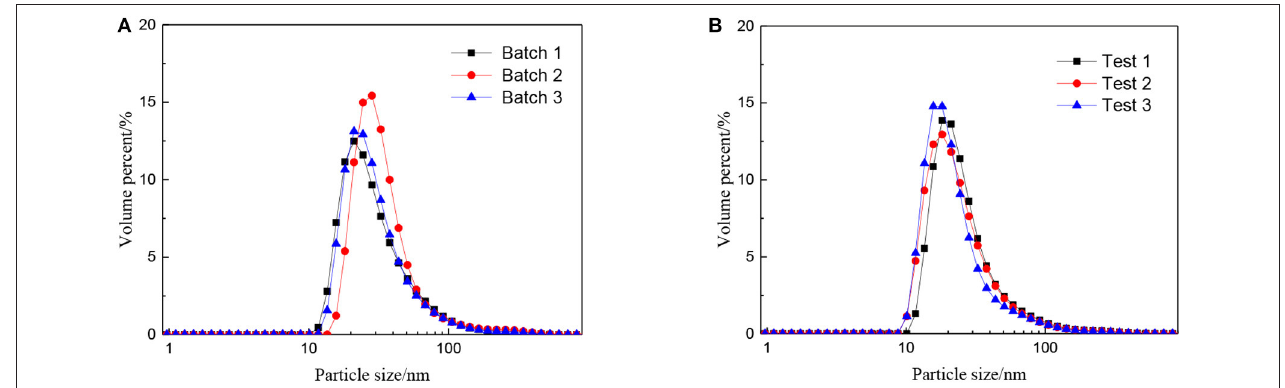
FIGURE 3 | Particle size distributions of the zirconia sols from (A) three batches and (B) one sample tested three times